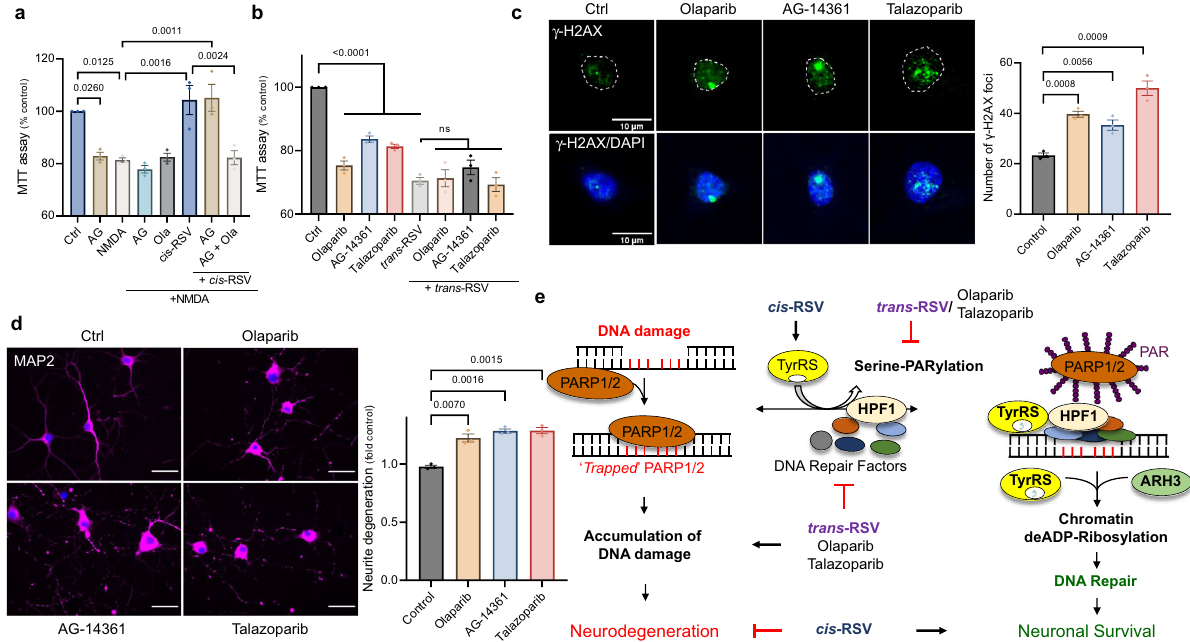
Fig. 9 PARP inhibitors are neurotoxic in HR-de fi cient post-mitotic neurons and a potential mechanism of the opposite effects of cis -and trans -RSV on neuronal survival. a PARP is required for cis-RSV-mediated neuroprotective effects . Rat cortical neurons (DIV 9) were treated with NMDA (50 µ M for 5 min), AG-14361 (AG, 10 μ M), olaparib (Ola, 10 μ M) either alone or in combination with cis -RSV (50 μ M) for 24 hr. Cells were then exposed to NMDA (500 µ M for 5 min) and viability was assessed using MTT assay after 24 hr. b PARP1 inhibitors are neurotoxic and do not affect trans-RSV-mediated neurotoxicity . Rat cortical neurons (DIV 9) were treated with olaparib (10 μ M), AG-14361 (10 μ M) and talazoparib (2 μ M) either alone or in combination with trans -RSV (50 μ M) for 72 hr. c PARP1 inhibitors induce DNA damage in HR-de fi cient post-mitotic neurons . Immunostaining images (scale bar, 10 µ m) for γ -H2AX foci (green; DAPI – nuclear marker, blue) in cortical neurons (DIV 10) after treatment with olaparib (10 μ M), AG-14361 (10 μ M) and talazoparib (2 μ M) for 24 hr. The graph represents the average number of γ -H2AX foci per n ≥ 30 neurons per treatment condition for n = 3 experiments. d PARP1 inhibitors induce neurite degeneration . Representative images (scale bar, 20 µ m) for cortical neurons following olaparib (10 μ M), AG-14361 (10 μ M) and talazoparib (1 μ M) treatment for 24 hr (MAP2 – neurite marker, magenta and DAPI – nuclear marker, blue). Neurons were immunoassayed with anti-MAP2 antibody and quanti fi ed for neurite degeneration. e Proposed mechanism of cis-RSV-mediated neuroprotection and trans-RSV-mediated neurotoxicity . All data represent mean ± SEM with statistical signi fi cance calculated using ANOVA with Š ídák ’ s test for multiple